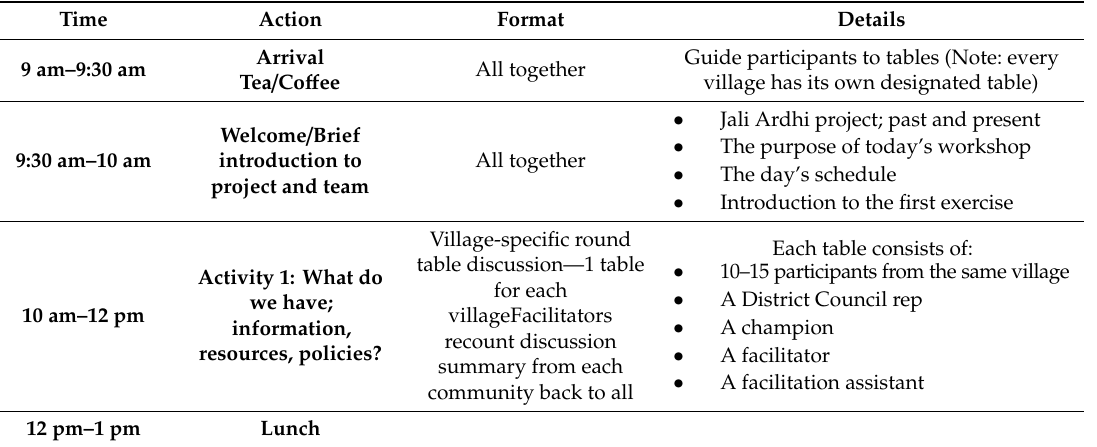
Table A1. Byelaw workshop structure.